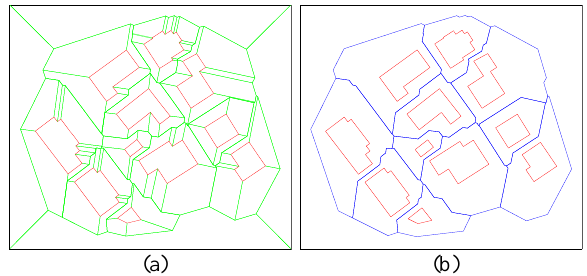
Figure 1. Straight skeleton (green) of an urban region including building footprints (red) (a) and resultant cells (blue) representing their influence area (b).